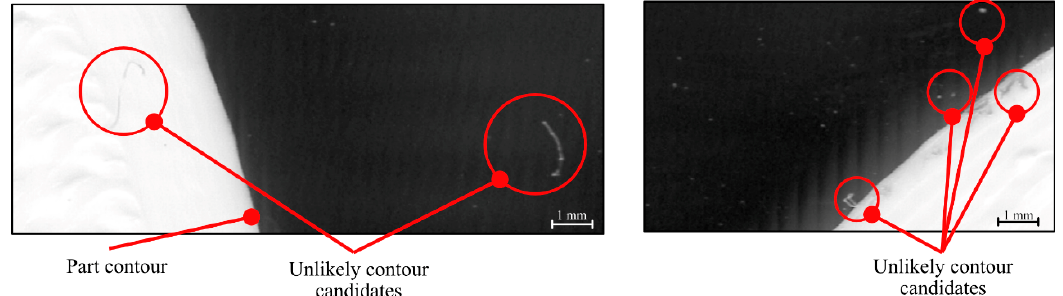
Figure 5. Unlikely contour candidates derived from image hindrances and odd elements.